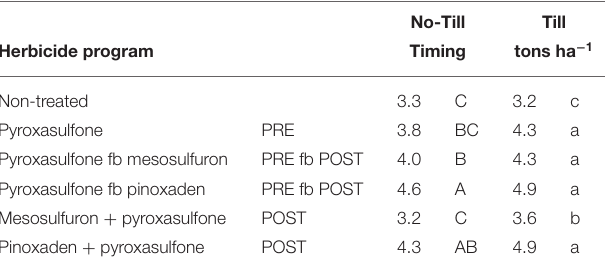
TABLE 6 | Winter wheat yield averaged across experiment locations (Hertford and Salisbury, North Carolina) and years (2013 and 2014); experiments were separated by tillage